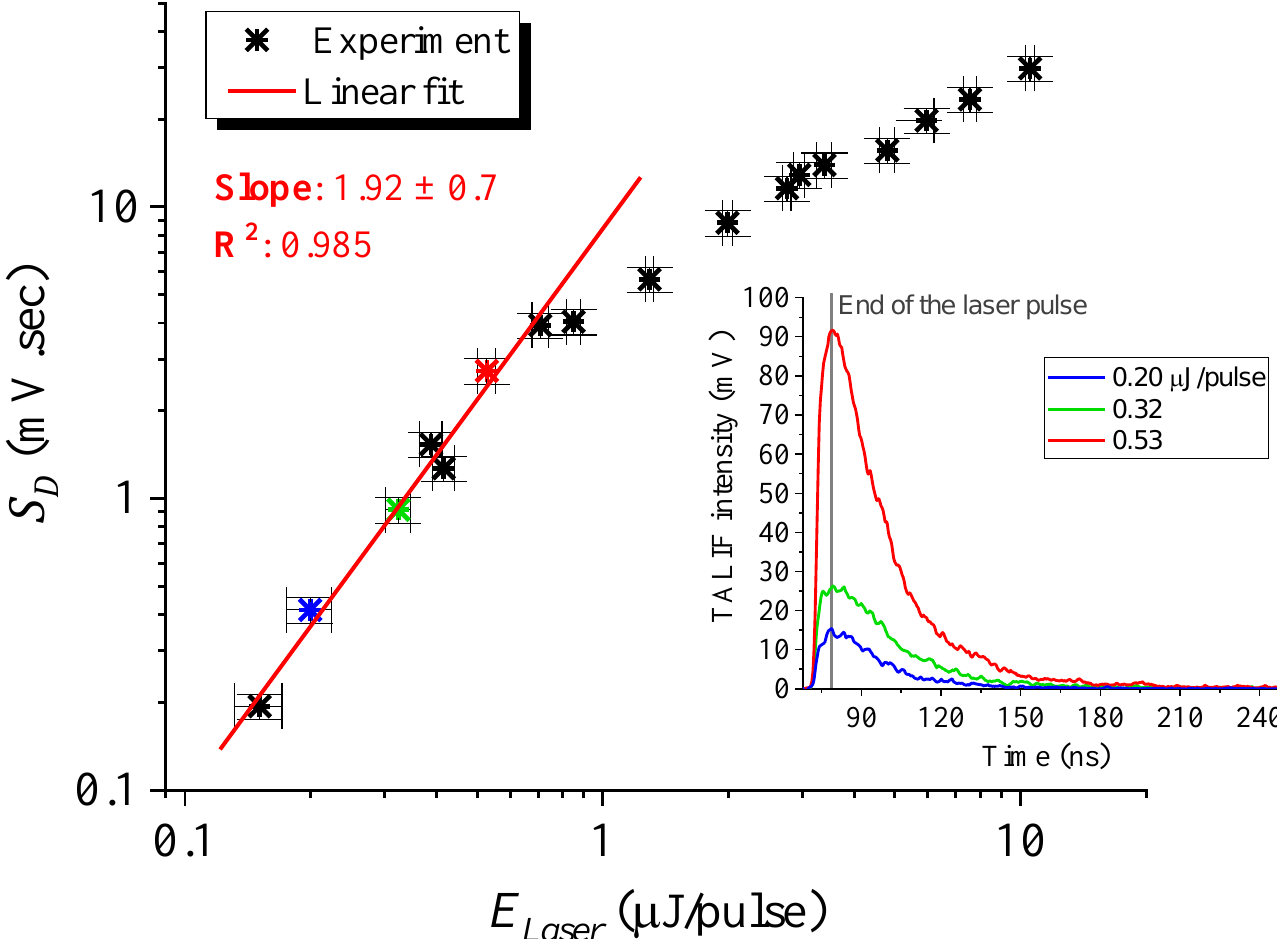
Figure 5. Time–integrated ps–TALIF signal ( S D , stars) in Kr at 4 mbar as a function of E Laser . This was obtained by integrating TALIF signals such as those given in the inset for different E Laser (quadratic regime). These correspond to the colored stars in the S D plot versus E Laser .